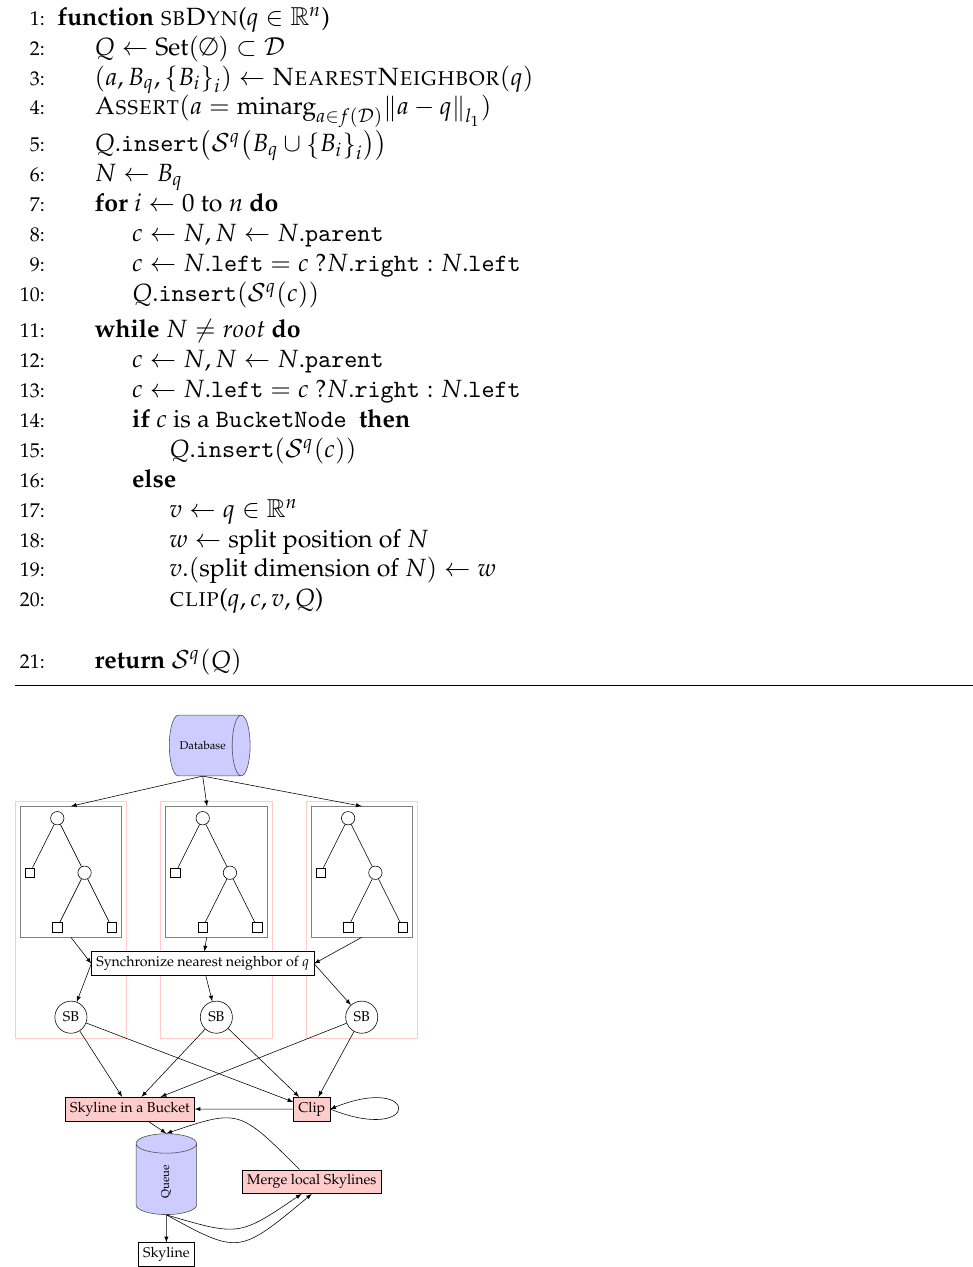
Figure 4. Flow diagram of the parallel Skyline Breaker algorithm ([4], Figure 1). Each thread maintains one LSD tree, which gets populated by the data from a single database source. After reading the data, each thread computes the nearest neighbor of q with respect to the l 1 -norm. These neighbors are synchronized across the threads. After that, the Skyline Breaker (SB) algorithm uses these neighbors for clipping the tree. Potential skyline points are put into a queue that is finally merged into the answer set S q ( D )